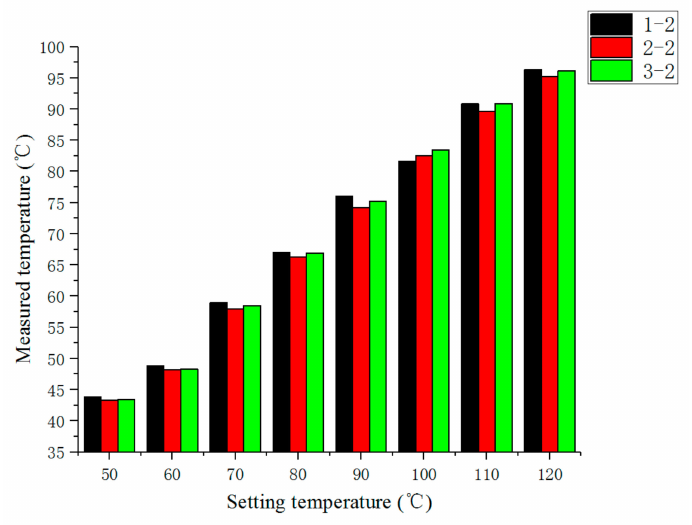
Figure 16. Comparison of the steady-state temperature measurements at the second measuring point of each temperature